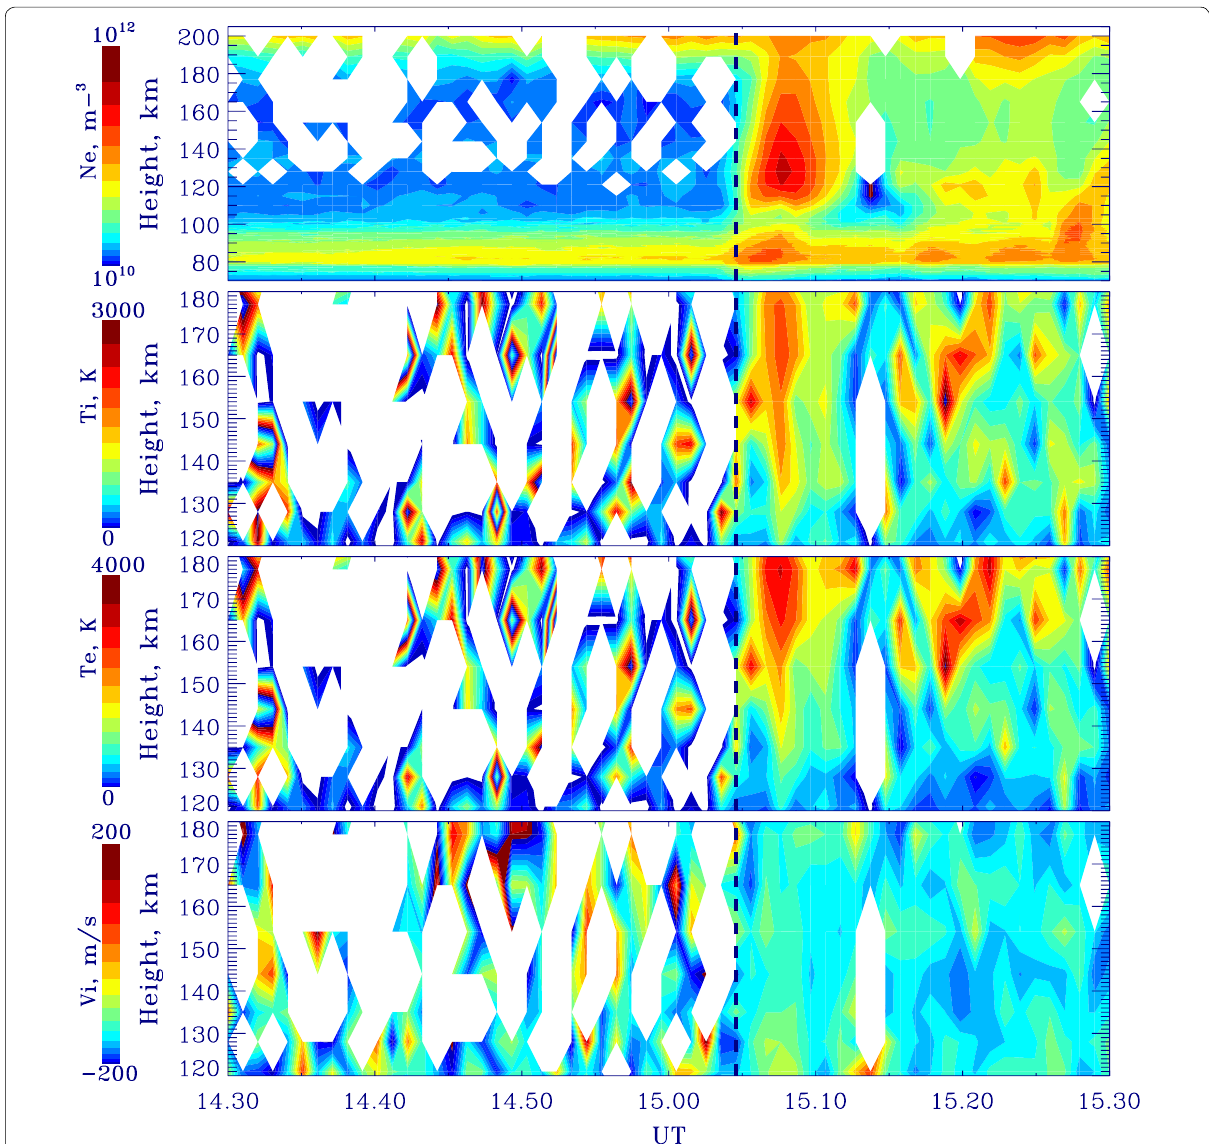
Fig. 12 Altitude variations of ionospheric parameters measured by EISCAT during 1430–1530 UT: electron density N e , ion temperature T i , electron temperature T e , and ion velocity V i . Dashed vertical line denotes the moment of PI recorded in the TRO magnetometer